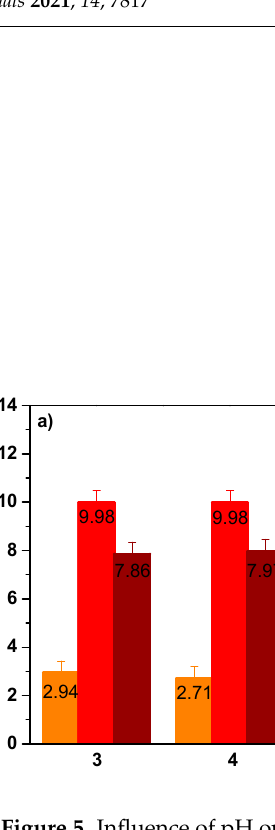
Figure 5. Influence of pH on adsorption of ( a ) AR18 and ( b ) Cu(II) on NaP1, NaP1CS and NaP1H (m = 0.1 g, t = 120 min., A = 7, 180 rpm, pH = 3–9).